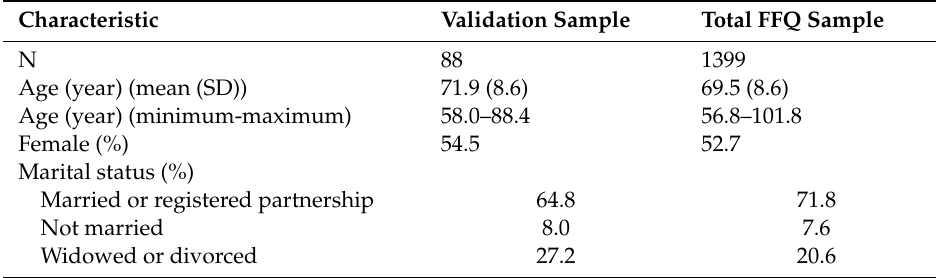
Table 1. Characteristics of the 88 validation study participants (those with a completed food frequency questionnaire as well as three 24-hour dietary recalls) and all 1399 participants (those with complete food frequency questionnaire data) of the Longitudinal Aging Study